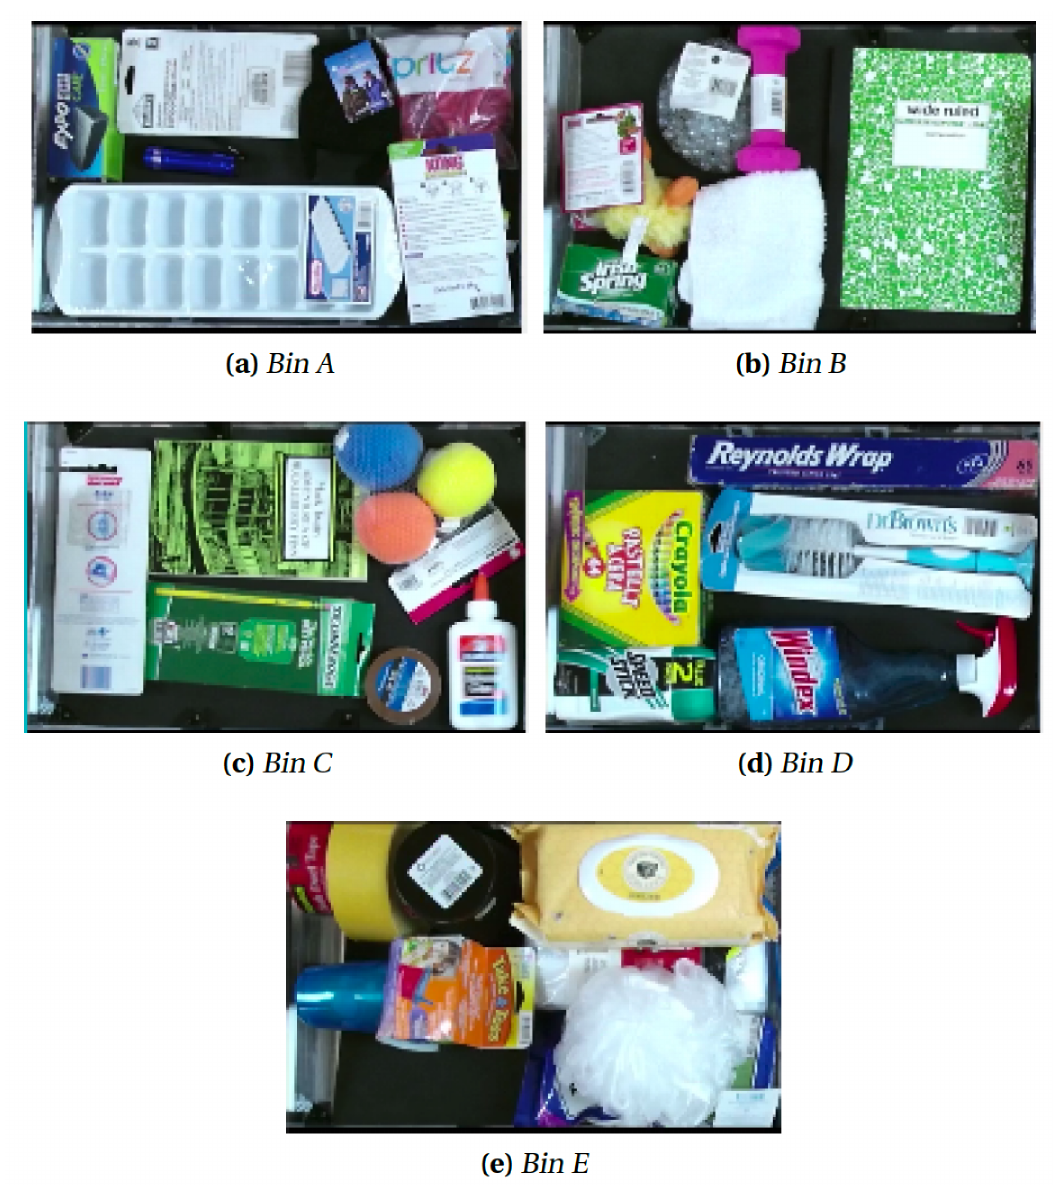
Figure 21. Initial setup for Test